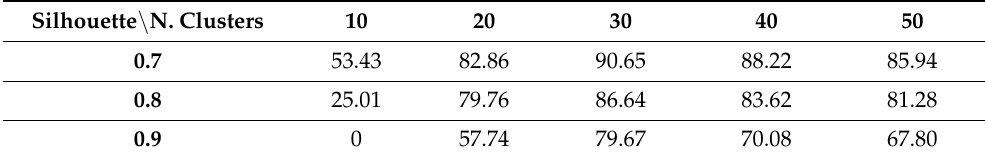
Table 54. Clustering performance in terms of silhouettes using the reduced dataset with SPQR applied to normalized data.